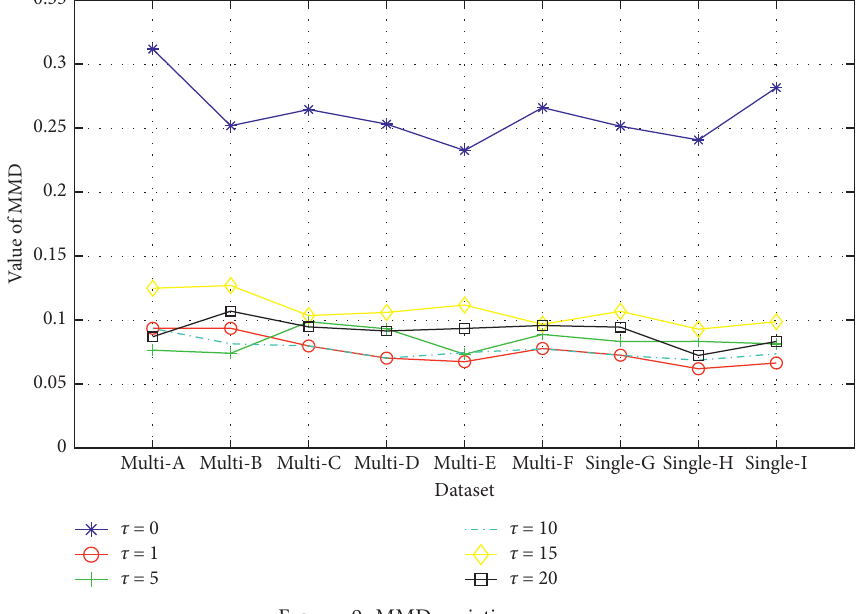
Figure 9: MMD variation